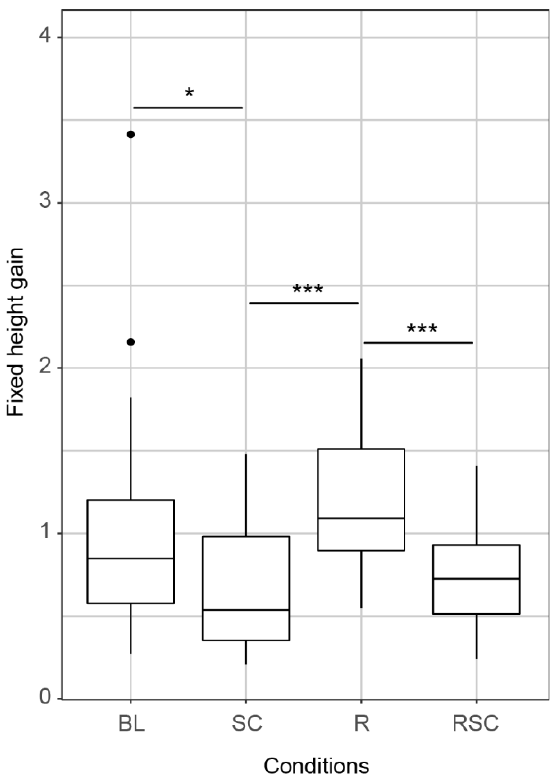
Figure 2. Boxplots of fixed height gain on the TBT (i.e., an index that reflects the height gained per block added adjusted according to the duration of the trial) per condition. The x axis gives the different conditions: Baseline (BL), Single Collapse (SC), Record (R), and Record-Single Collapse (RSC). Horizontal lines through the boxes give median values, box limits represent the 1st and 3rd quartiles. Whiskers extend from the limits of the boxes to the smallest and largest values no further than 1.5 times the interquartile range. Outliers (filled circles) lay beyond this range. Horizontal bars across the top of boxplots indicate statistical significance between two conditions. Asterisks represent levels of significance: * p < 0.05; *** p < 0.001.